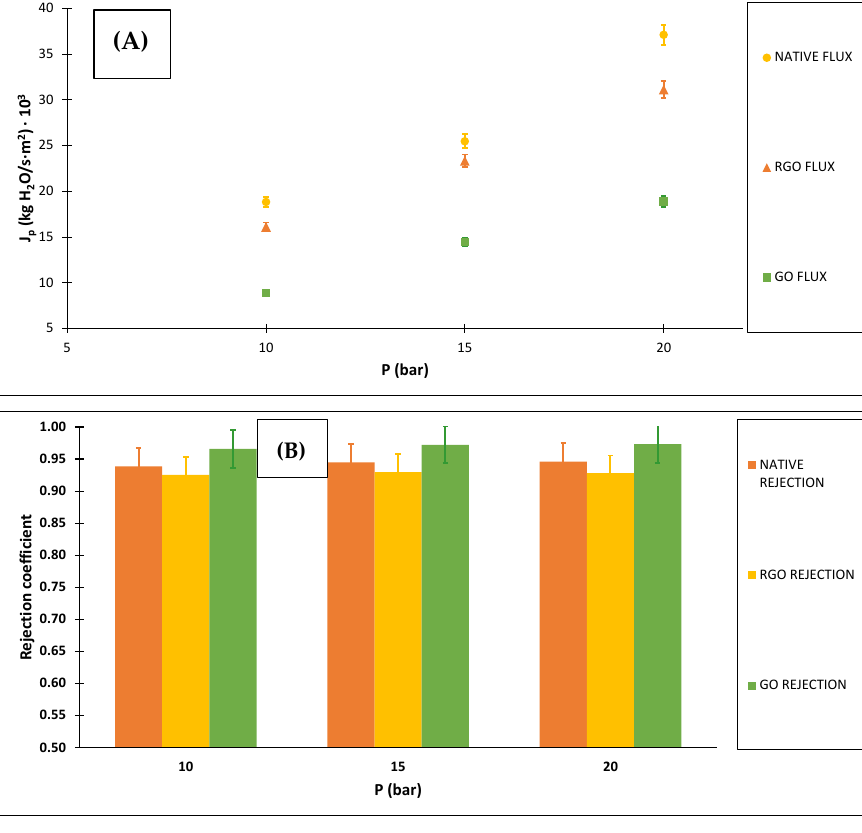
Figure 5. Permeate mass flows ( A ) and rejections of saline solutions ( B ) against pressures.